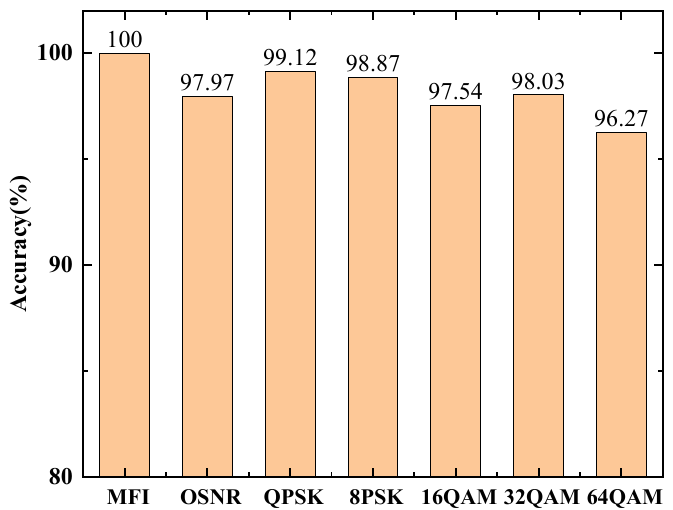
Figure 13. Accuracies for MFF-Net trained on data from two different bitrates (56 Gbit/s, 112 Gbit/s).